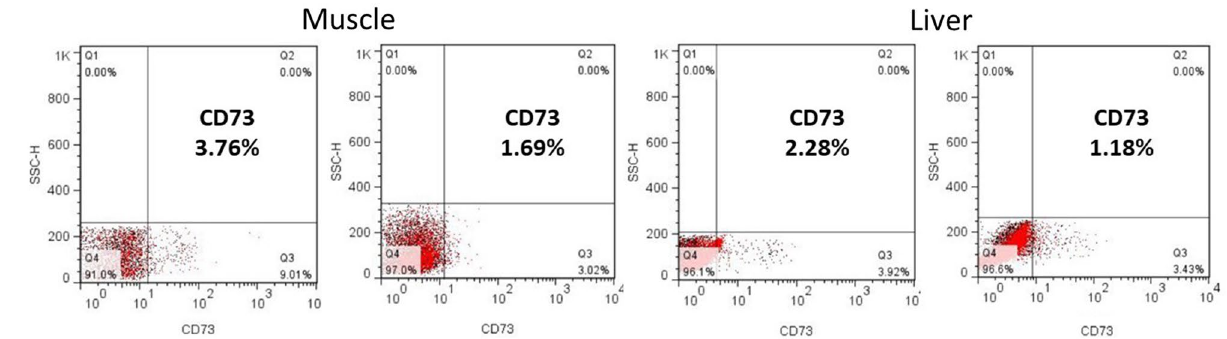
Figure 5. Flow cytometry analysis of muscle and liver in SMA mice after hAFSC transplantation. Muscle and liver of SMA mice with hAFSC transplantation were positive for CD73, a surface marker of MSC. Black spots indicated negative controls, and red spots indicated CD73 positives. hAFSC human amniotic fluid stem cell; MSC mesenchymal stem